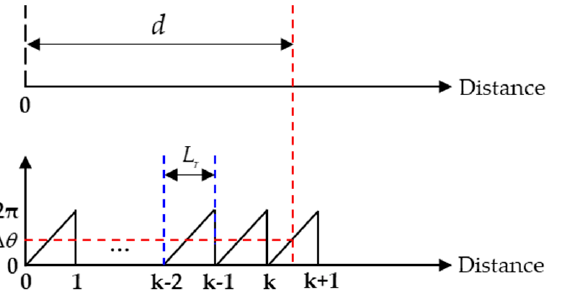
Figure 16. Relation between standard ToF method where d = ( c · ∆ t ) /2 and the combined method where d = 1/2 [( k − 1 ) + ( ∆ θ /2 π )] · ( c / ∆ f ) . Table 5. Performance comparison of several BFSK based ranging systems. Reference Range Accuracy Signal Processing Method